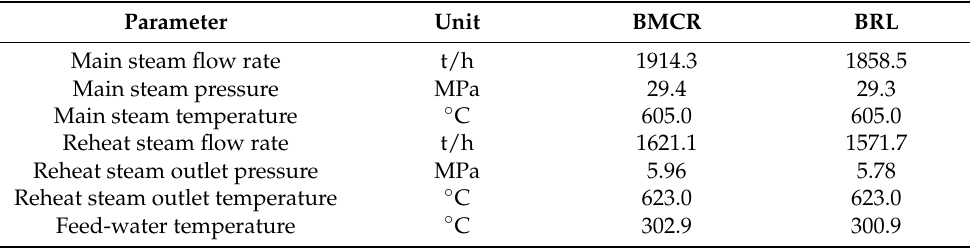
Figure 1. Schematic diagram of 660 MW ultra-supercritical CFB boiler. PH: preheater, SH: superheater, RH: reheater. Table 1. Main design parameters of boiler.